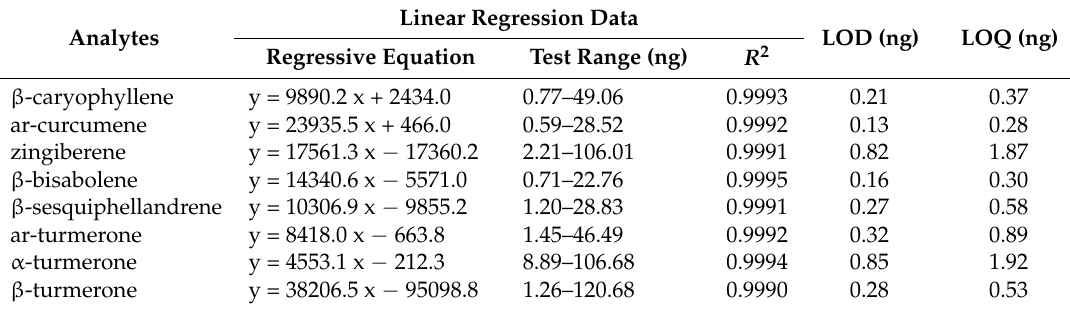
Table 3. Regression data, LOD, and LOQ of the investigated